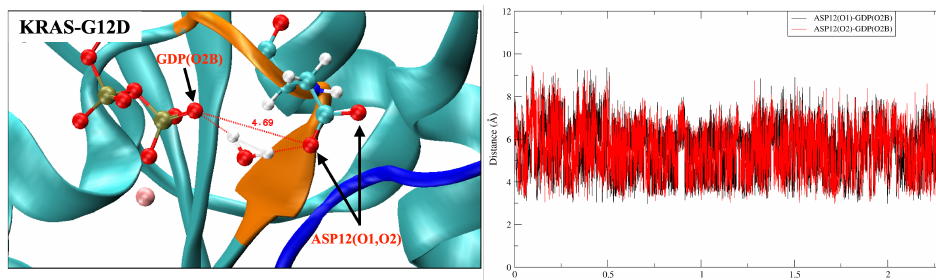
Figure A11. The dynamic water pocket II.